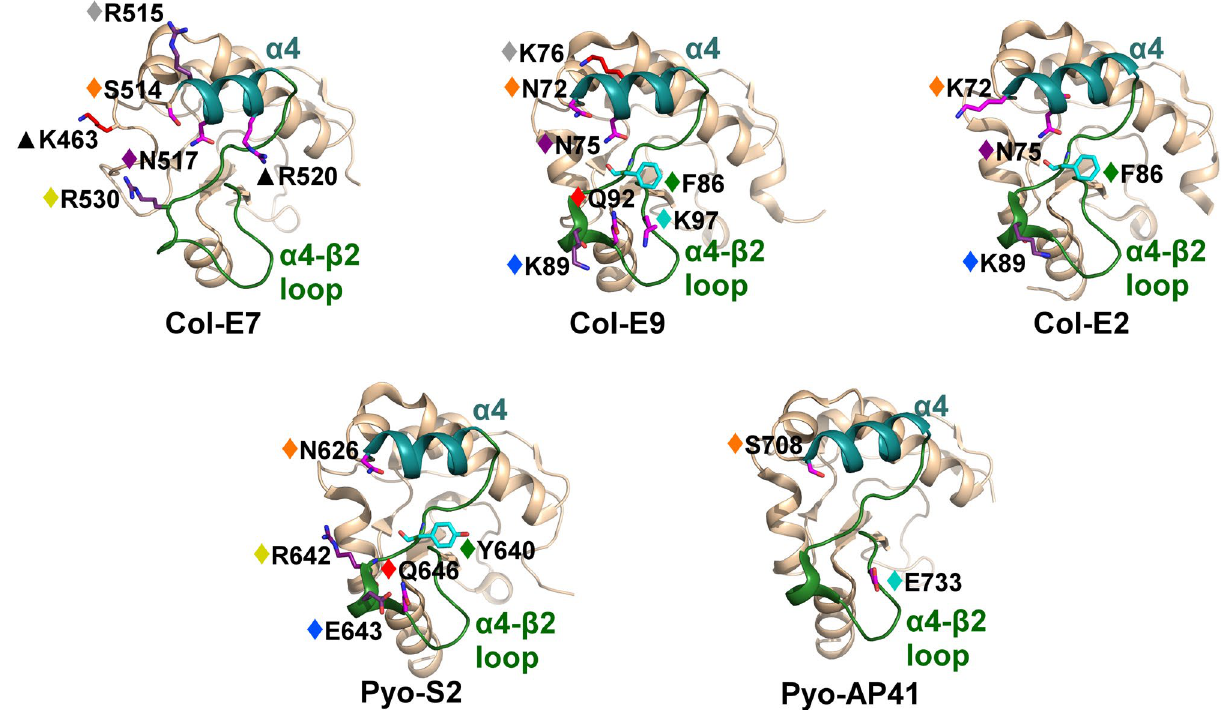
Figure 7. Varied electrostatic contributions of colicin/pyocin residues to interactions with the Im α3 region. Colicin residues that substantially contribute electrostatically to interactions with the Im α3 helix are shown as sticks, colored according to their energy contributions, as in Fig. 3. Colicin residues that contributed similarly to interactions across multiple members are marked with diamonds, colored as follows (the corresponding E7 position number, as in Fig. 3B, is also noted): orange (E7#514), gray (E7#515), purple (E7#517), green (E7#528), yellow (E7#530), blue (E7#531), red (E7#534), and cyan (E7#539). The α4 helices are colored cyan and the α4– β2 loops are colored green. Residues that contributed to interactions with the cognate immunity protein only in one complex are marked with black triangles. Colicin/pyocin structures are rotated 70° about the Y-axis relative to Fig.